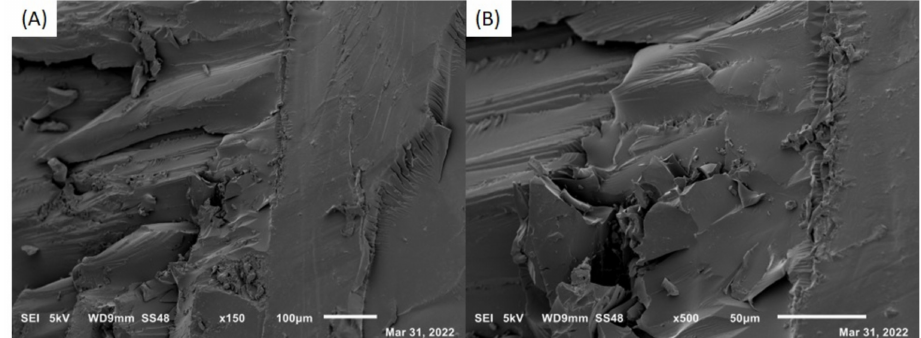
Figure 8. SEM micrographs ( A ) (150 × ) and ( B ) (500 × ) of pure DGEBA epoxy